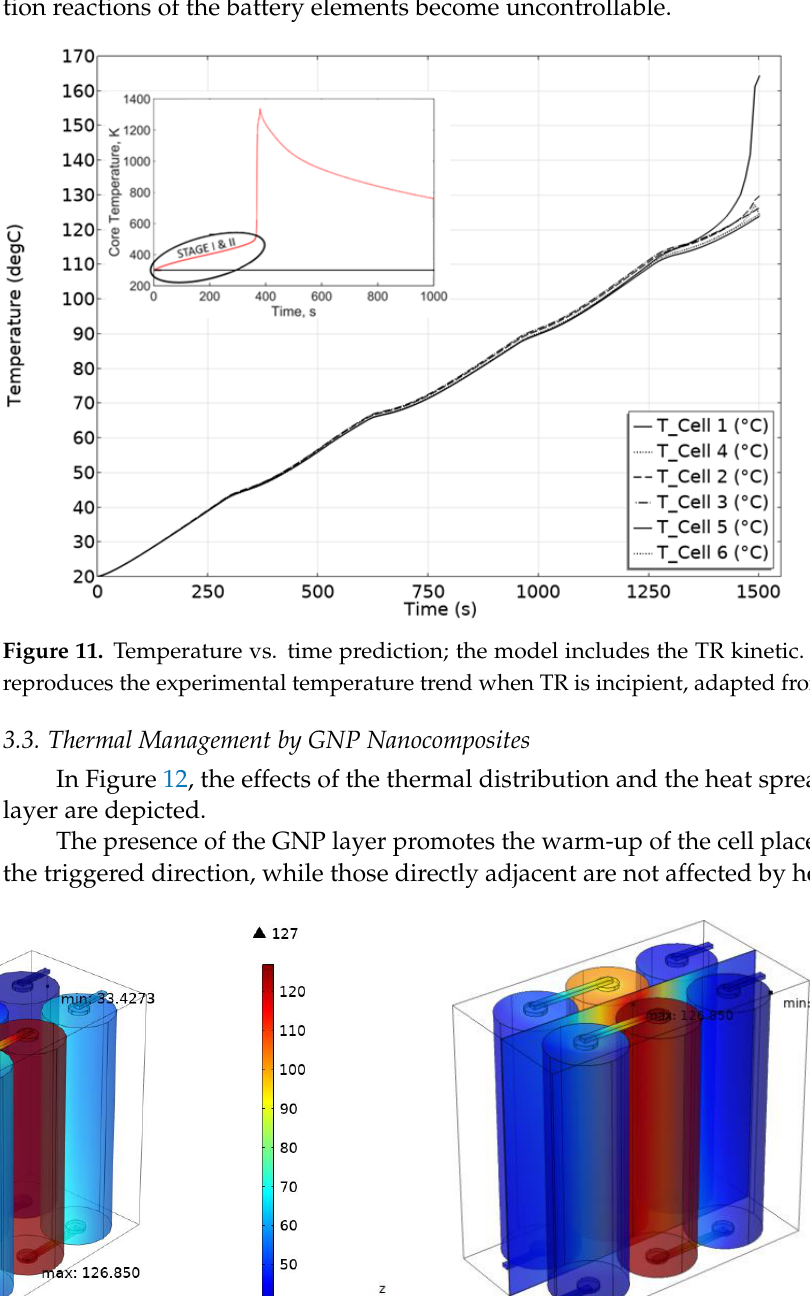
Figure 10. Temperature distribution inside the battery pack as a result of the decomposition reac- tions: ( a ) instant t = 0; ( b ) t = 500 s; ( c ) t = 1000 s and ( d ) t = 1500 s.